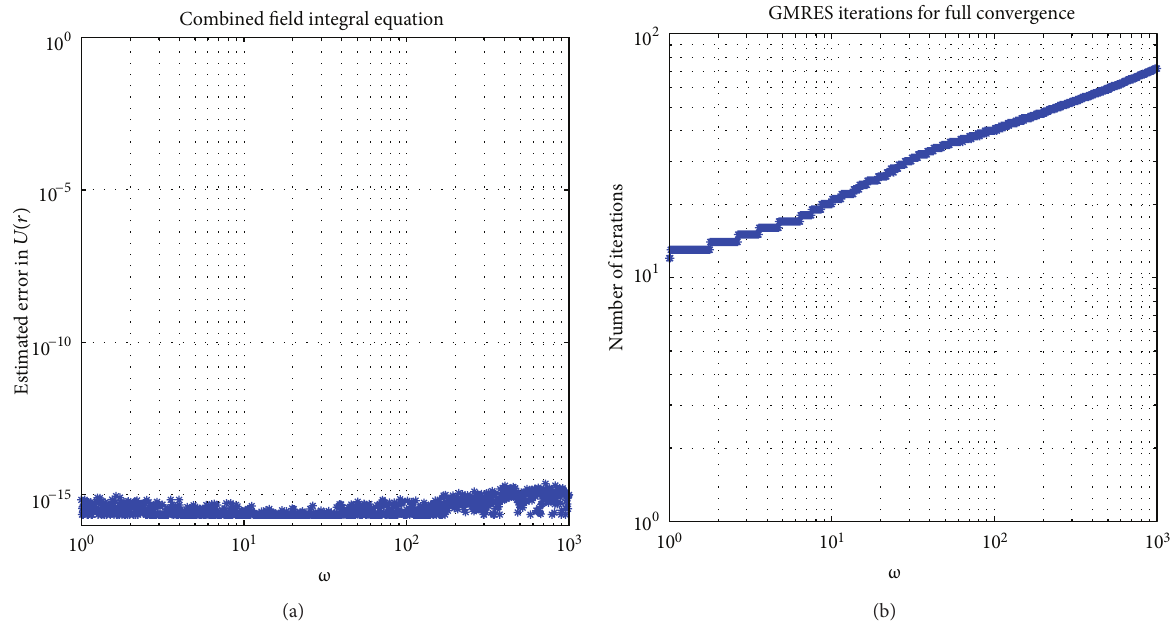
Figure 14: The exterior Dirichlet problem for Helmholtz equation with RCIP applied to (55). The program demo11.m is used with Γ as in (1), and 𝜃 = 𝜋/2 . The boundary condition 𝑔(𝑟) of (51) is generated by a point source at (0.3, 0.1) . (a) The absolute error in 𝑈(𝑟) at 𝑟 = (−0.1, 0.2) . (b) The number of GMRES iterations needed to meet an estimated relative residual of 𝜖